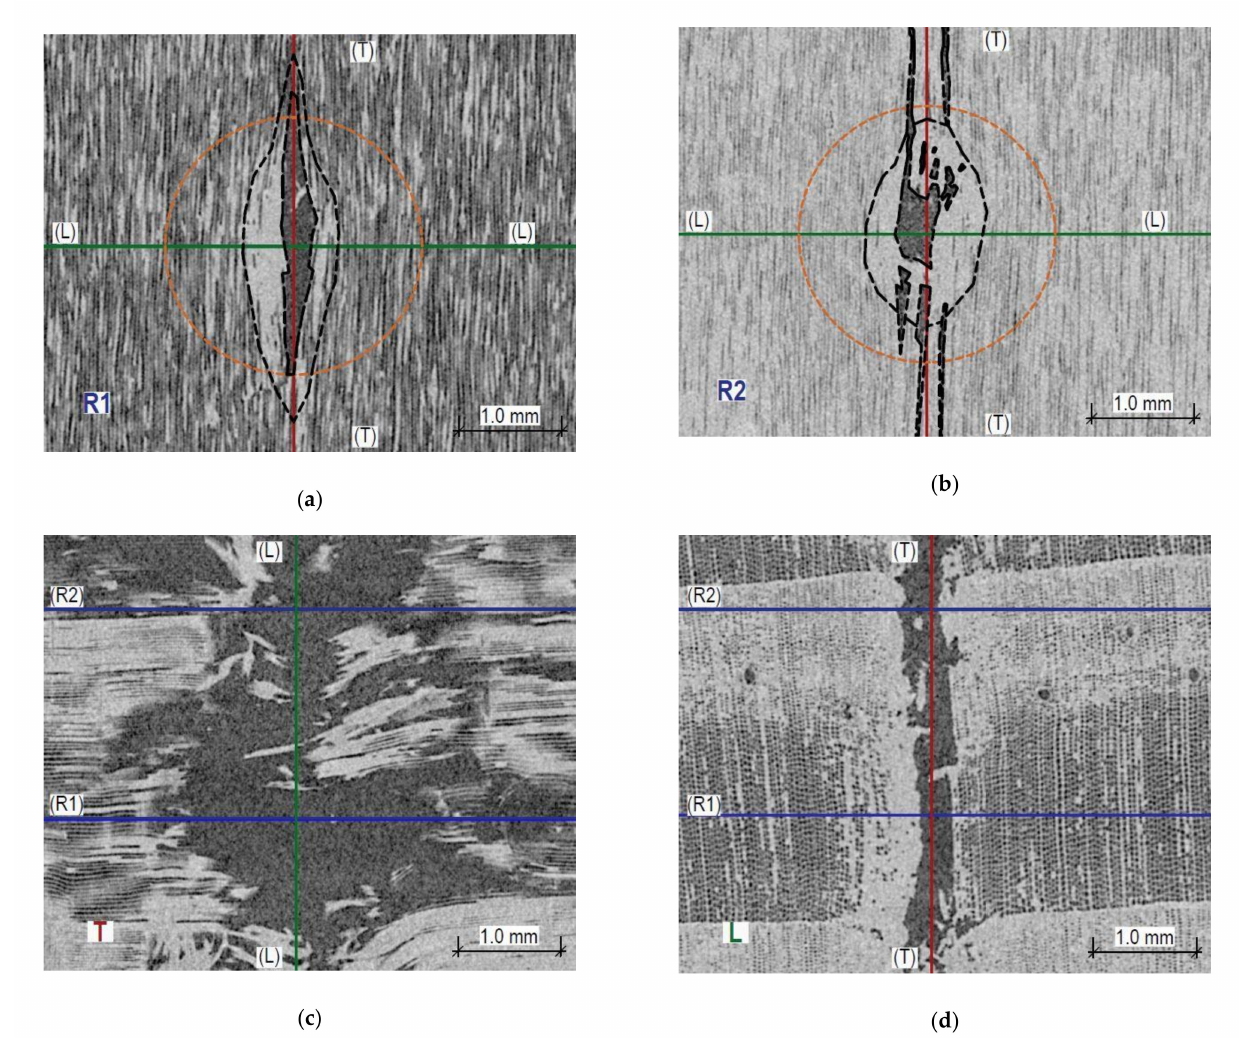
Figure 14. Sections through the opening resulting from the sclerometric test on the sample in the fibre saturation state. ( a ) Cross-section within earlywood R1—tangential section of wood can be seen; ( b ) Cross-section within latewood R2—tangential section of wood can be seen; ( c ) Longitudinal section T—radial section of wood visible; ( d ) Longitudi- nal section L—cross-section of wood